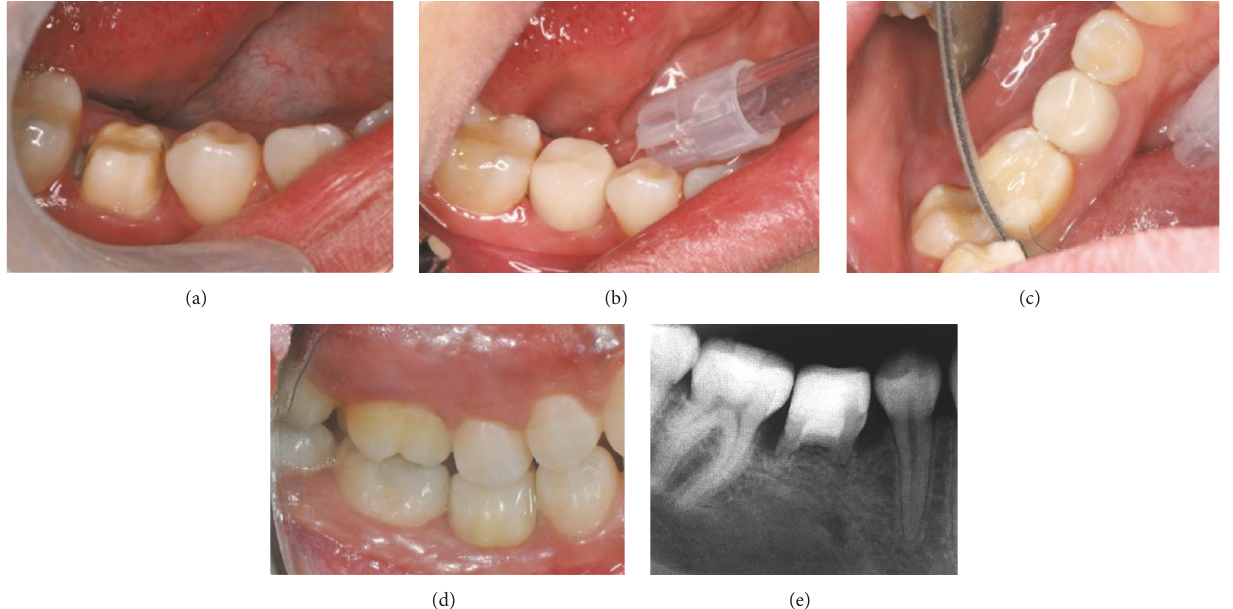
Figure 2: Crown preparation and cementation. (a) Tooth preparation with chamfered margin. (b–d) Intraoral views of the crown after cementation. (e) Postoperative radiograph of the crown.